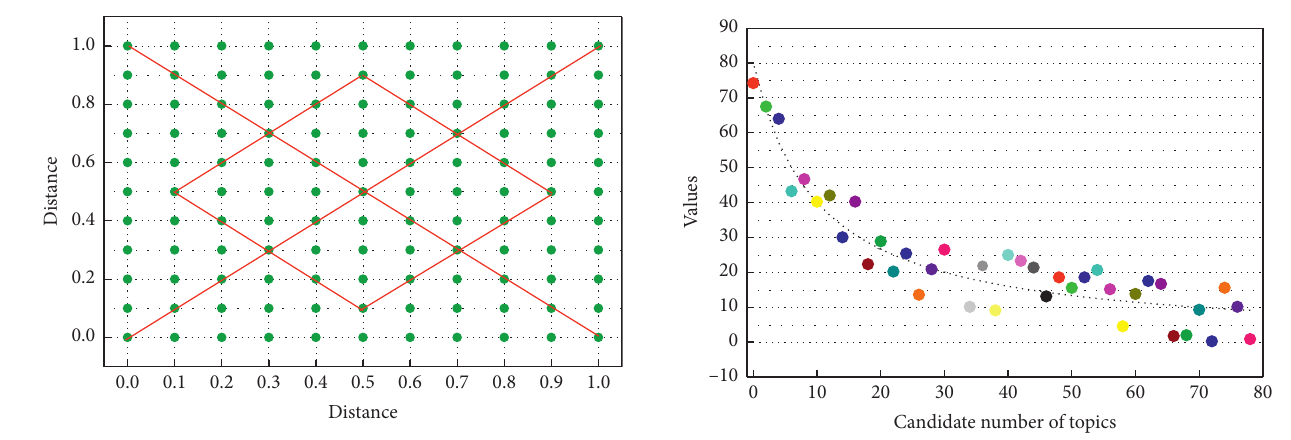
Figure 8: Simulation of the path optimization algorithm.